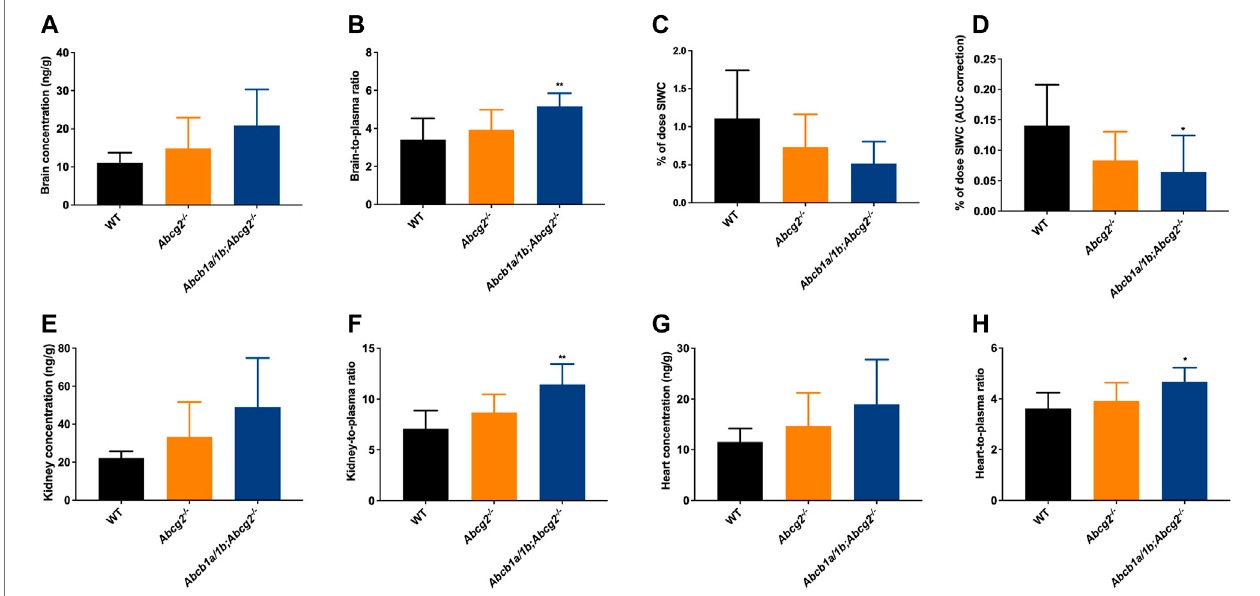
FIGURE 3| Ibogaine brain, kidney and heart concentrations (A,E,G) , tissue-to-plasma ratios (B,F,H) , and smallintestine together with the fecal content (SIWC) as percentage of dose (C) corrected for the plasma AUC (D) in female wild-type (WT), Abcg2 − / − , and Abcb1a/1b;Abcg2 − / − mice, over 2 h after oral administration of 10 mg/kg ibogaine ( n = 6 – 7). Data are presented as mean ± SD. *, p < 0.05; **, p < 0.01 compared to wild-type mice.